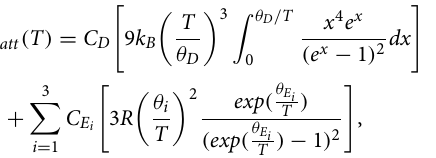
+ T 50 K (left y-axis) and the ≤ ≤